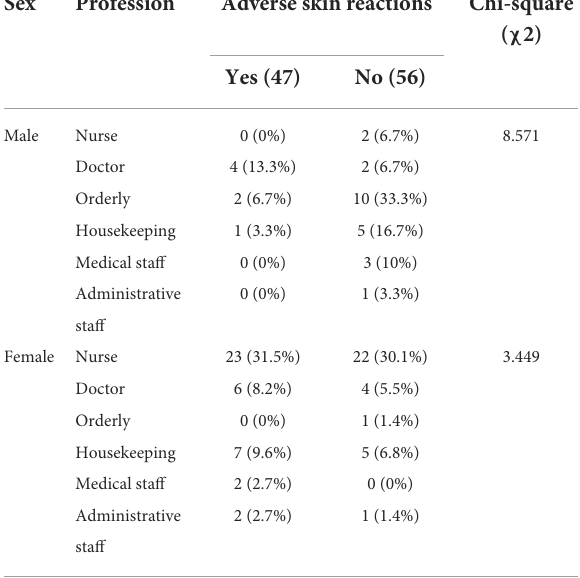
TABLE 3 Gender specific influence on the use of protective equipments by ( n =